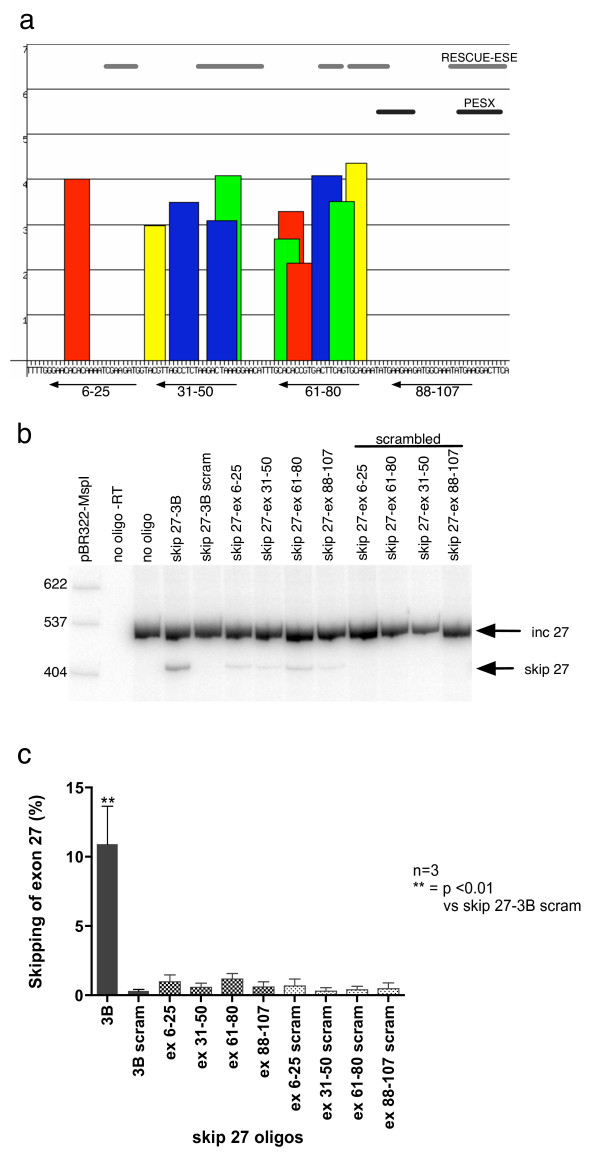
Effect of ASOs targeting APOB exon 27 sequences. (a) ESEfinder output for APOB exon 27, using version 2.0 matrices and thresholds [21]. Y-axis shows ESEfinder above-threshold scores for identified matches; X-axis corresponds to the exon 27 sequence. Red = SF2/ASF, blue = SC35, green = SRp40, yellow = SRp55. The light grey horizontal lines indicate the matches that were found by RESCUE-ESE [22]. The dark grey lines indicate the ESE candidates identified by PESXs server [23, 24]. ASOs were designed to bind to locations corresponding to ESE clusters, and these locations are represented below the X-axis by the arrows, which run from the 5' to 3' direction. (b) RT-PCR assay for exon 27 skipping with RNA from cells transfected with ASOs at 250 nM. Exonic ASOs 6–25, 31–50, 61–80, 88–107 weakly promote exon 27 skipping, whereas scrambled versions of these ASOs had no effect on exon 27 skipping. (c) Quantitative data from three independent experiments. Error bars show S.E.M. Overall repeated measures one-way ANOVA showed p < 0.0001, indicating significant differences between compared groups. Dunnett's multiple comparison test showed a significant difference between skip 27-3B and 3B scram (p < 0.01), but no statistically significant differences were seen between skip 27-3B scram and other skip 27 ASOs.